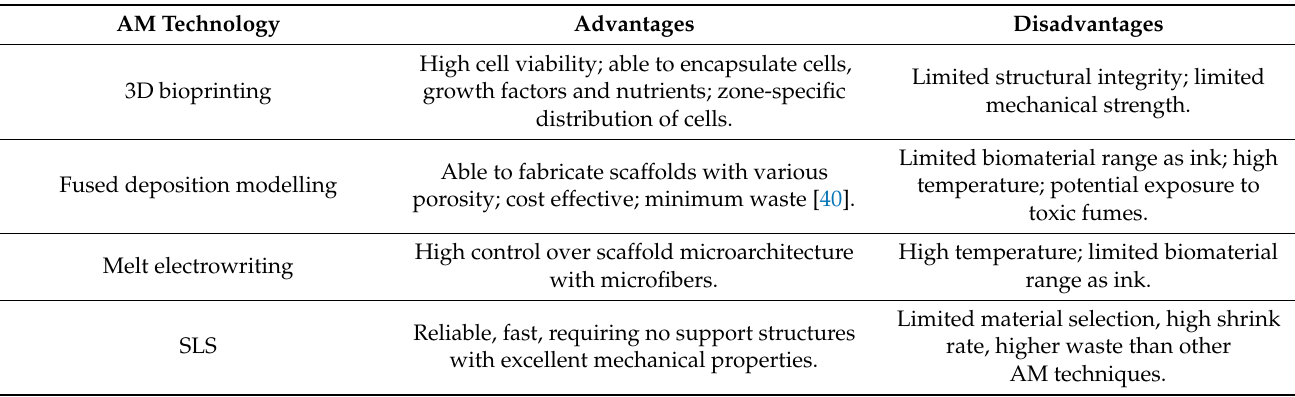
Table 2. Advantages and disadvantages of additive manufacturing technologies used for whole IVD tissue